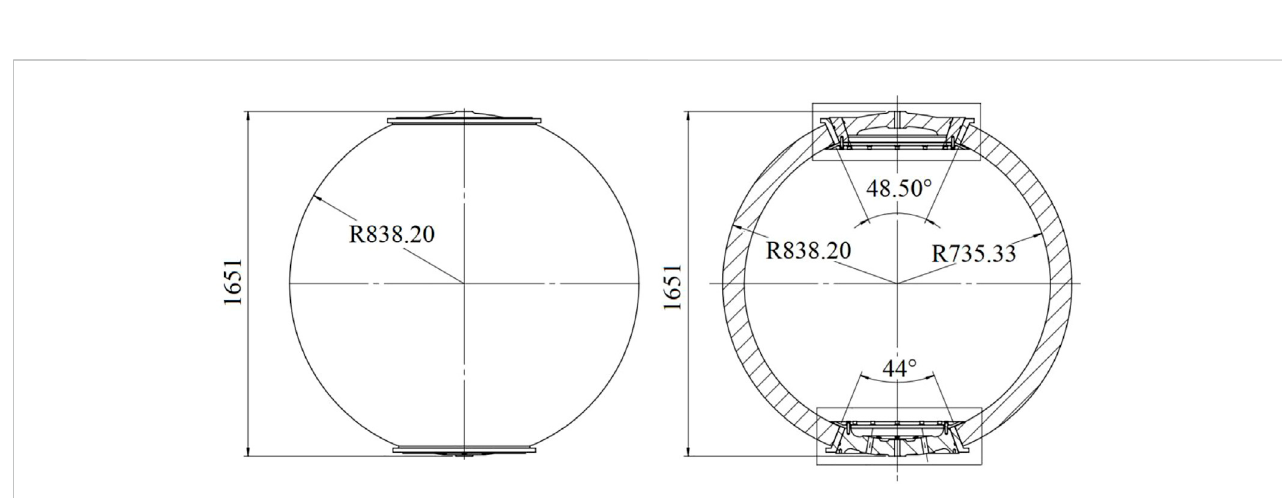
Structural diagram of fully transparent pressure